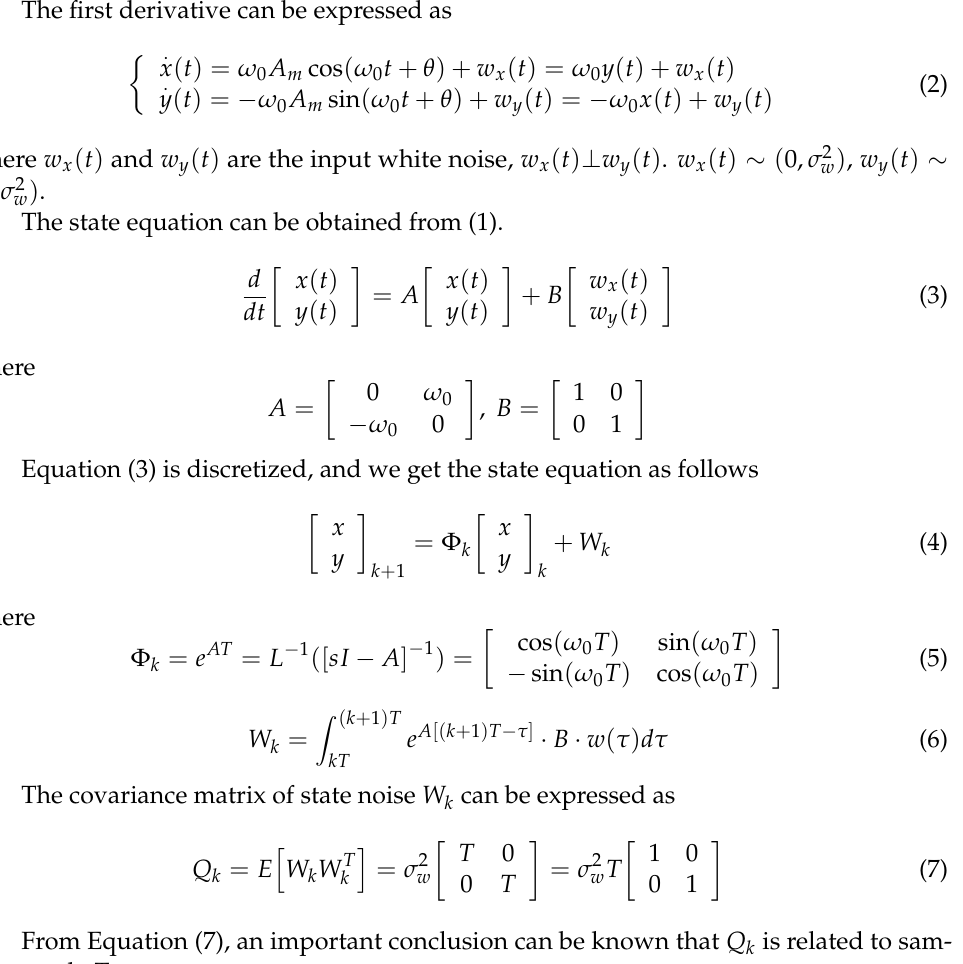
Figure 3. Diagram of the object circular movement being projected.